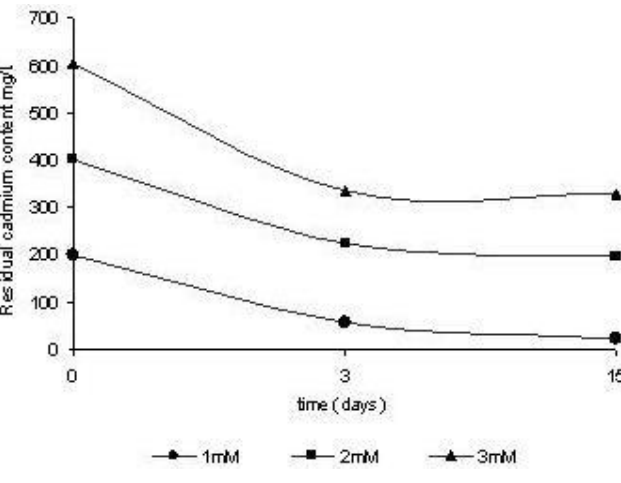
Figure 6. Removal of cadmium ions of culture by Trichoderma harzianum